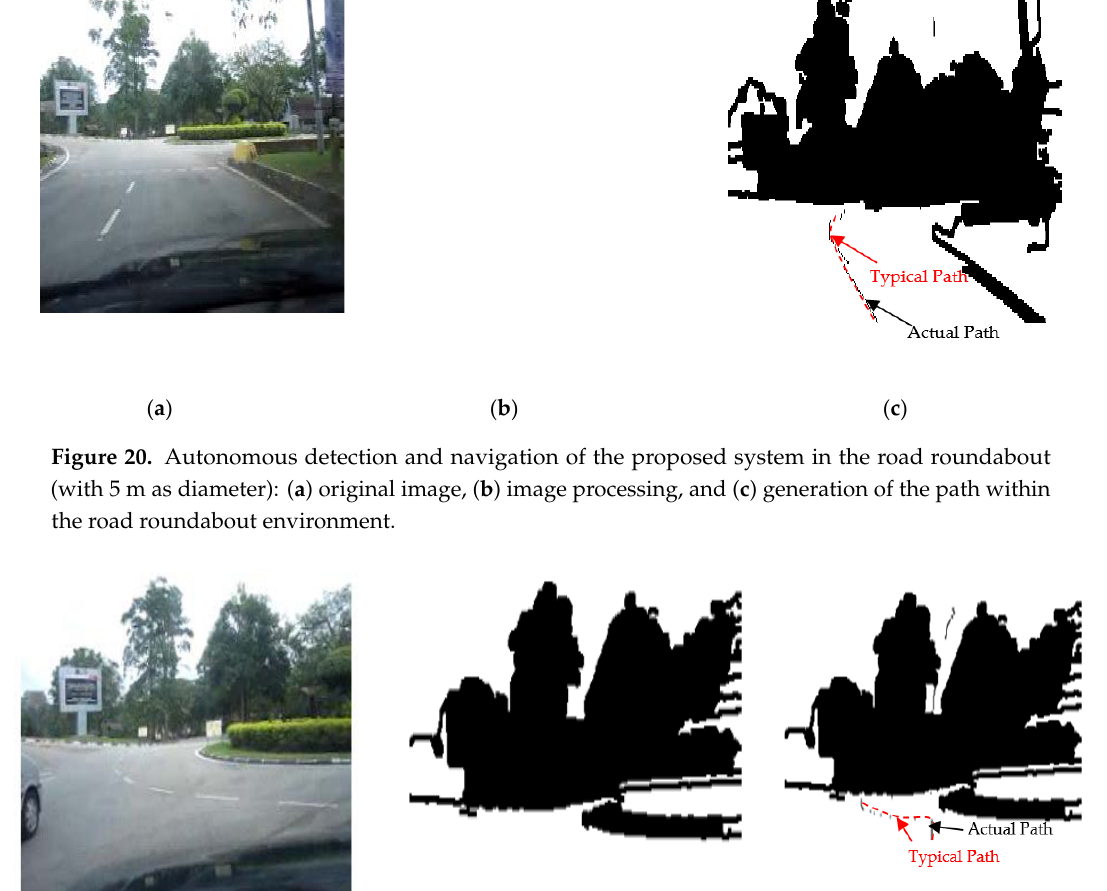
Figure 21. Autonomous detection and navigation of the proposed system in the road roundabout